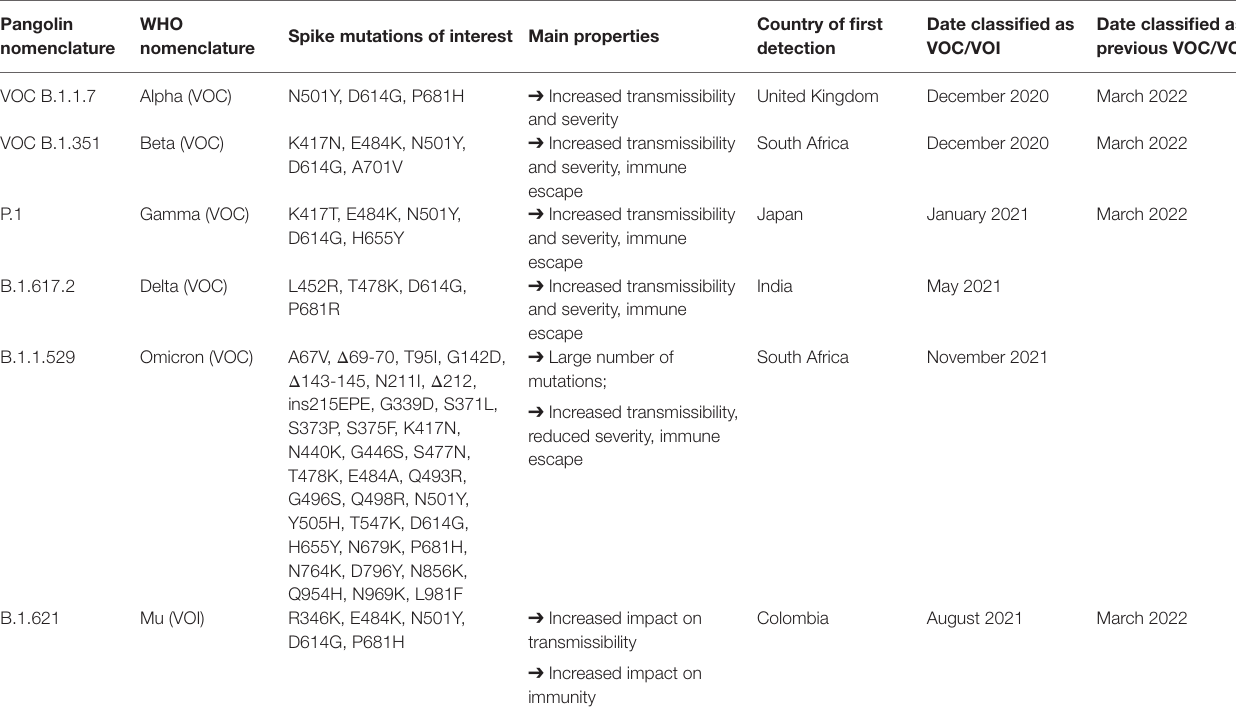
TABLE 1 | Description of variants of concern and variant of interest (CDC, 2021d; WHO, 2021c,d; European Centre for Disease Prevention and Control,